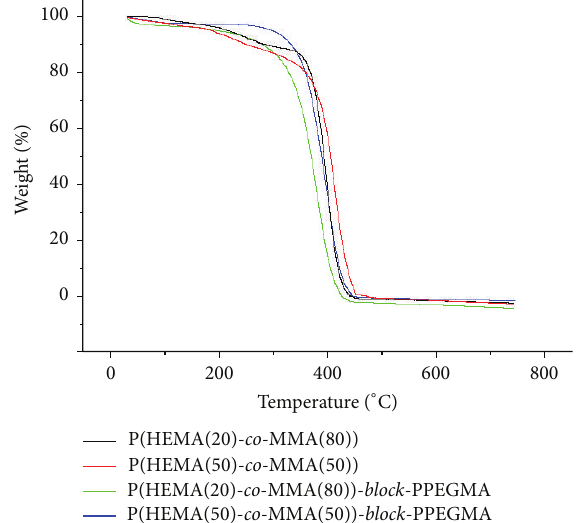
Figure 8: TGA curves of P(HEMA- co -MMA) ( 1b, 1d ) and P(HEMA- co -MMA)- block -PPEGMA ( 2b, 2d ).